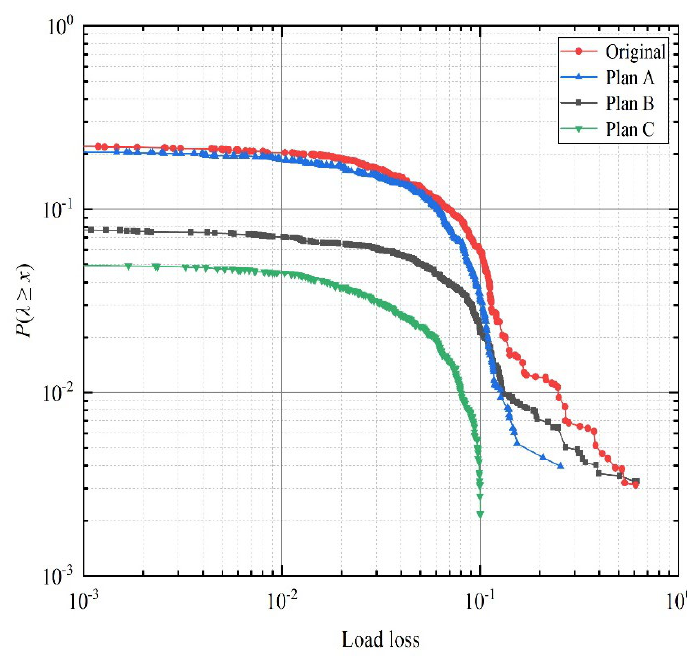
Figure 8. The result after adding the communication